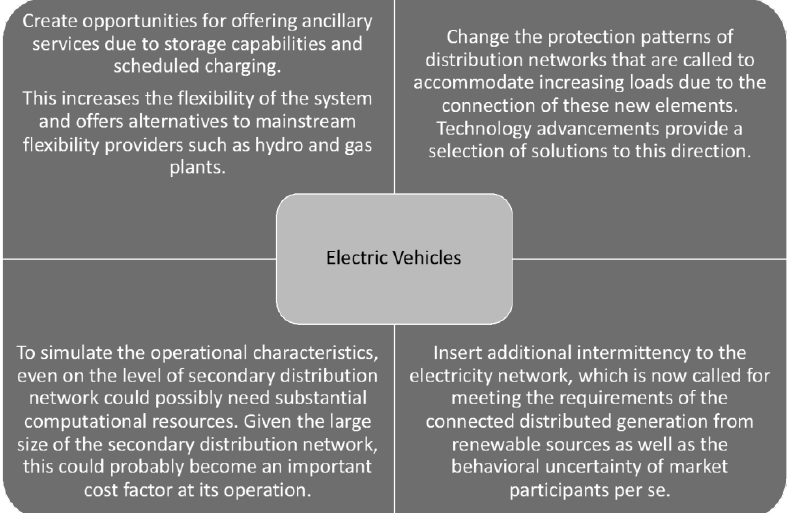
Figure 1. Power system enhancements due to the connection of electric vehicles.